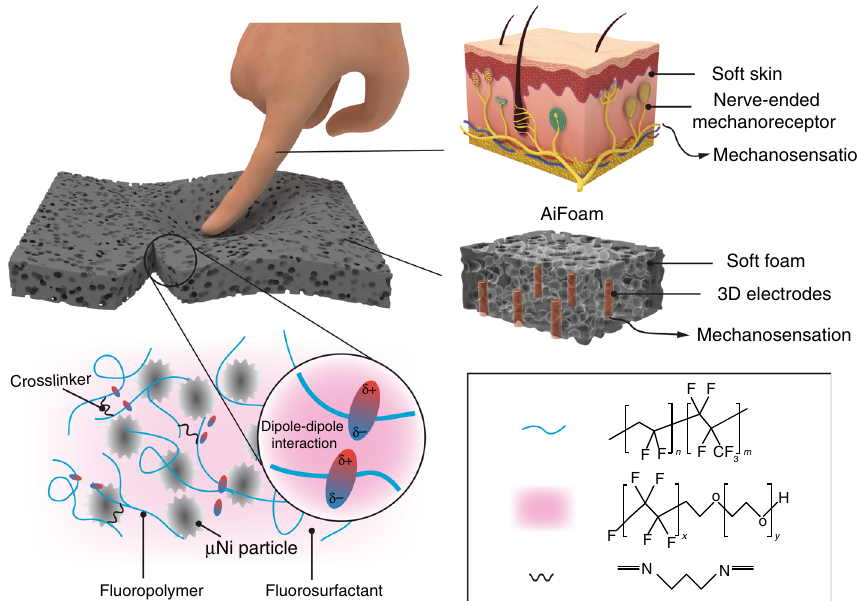
Fig. 1 Arti fi cially innervated pressure sensor that is low-modulus, elastic, and self-healing. Left The schematic diagram of the mechanism of the AiFoam material. The polymer chains (blue curves) are cross-linked by DAP (black curves) and surrounded by the fl uorosurfactant (pink color) to form the low- modulus base elastomer. Micro-nickel ( μ Ni) particles with surface nanostructure (gray particles) are mixed with the elastomer to form the foam material. The dipole – dipole interactions among the polymer chains and the surfactant molecule trap the surfactant within the polymer and enable the material to be self-healing. The AiFoam is fabricated by embedding three-dimensional electrodes in the foam material to mimic the innervations of the human skin. Right the schematic diagram of arti fi cially innervated foam (AiFoam) sensor ( middle ) imitating the somatosensory innervation system of human skin ( top ).